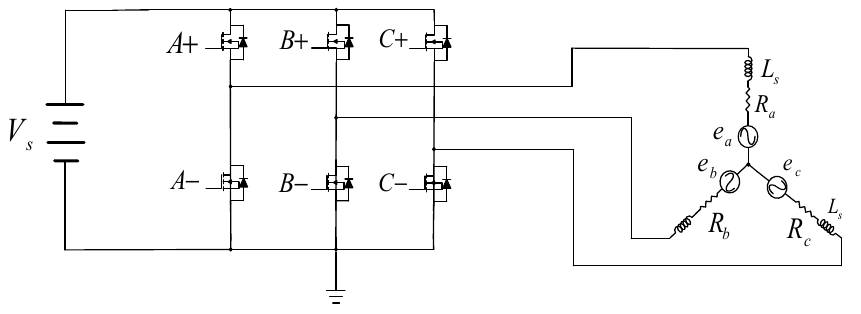
Figure 1. Typical three-phase inverter and PMSM.